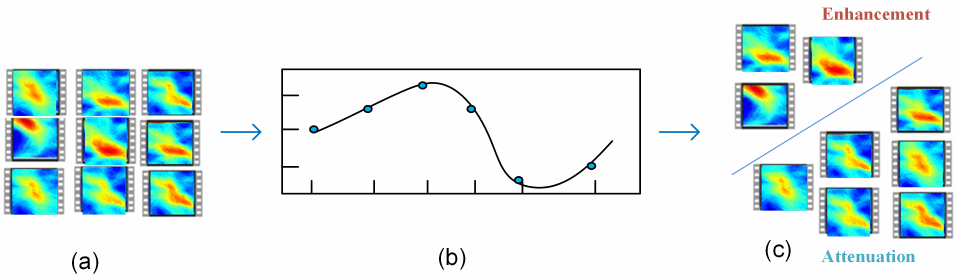
Figure 4. The ocean-front classification algorithms are based on strength and scale. These algorithms are very similar. First, the feature values are calculated from the video sequences ( a ). Then, these values are used to fit a curve ( b ). After that, we can extract points from the curve to form a matrix. Then, this matrix is processed and fed to softmax for classification. The scores hence can be acquired and used to label the enhancement and attenuation classes ( c